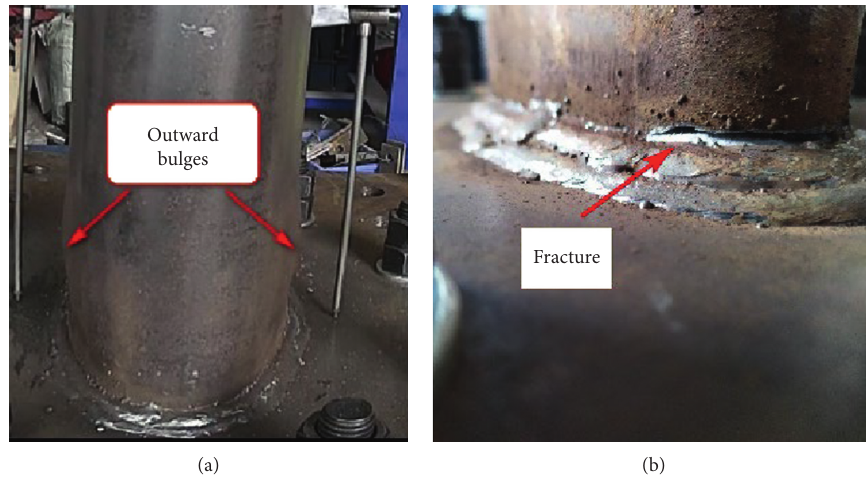
Figure 7: Typical failure modes of the specimens. (a) Local buckling. (b) Fracture of the steel tube.